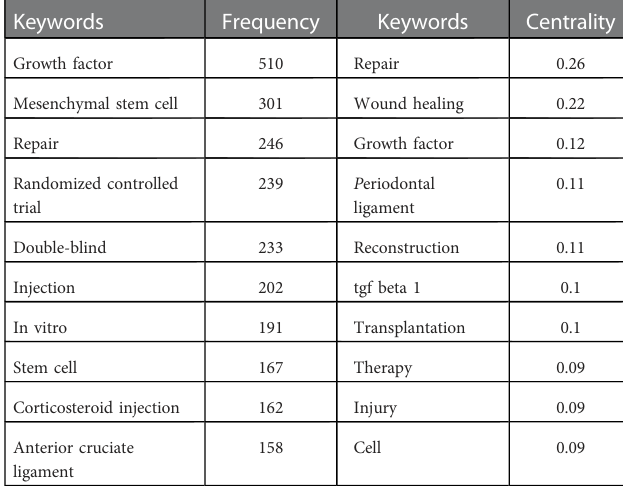
TABLE 4 Using platelet-rich plasma to treat ligament and tendon injuries high frequency keywords and centrality